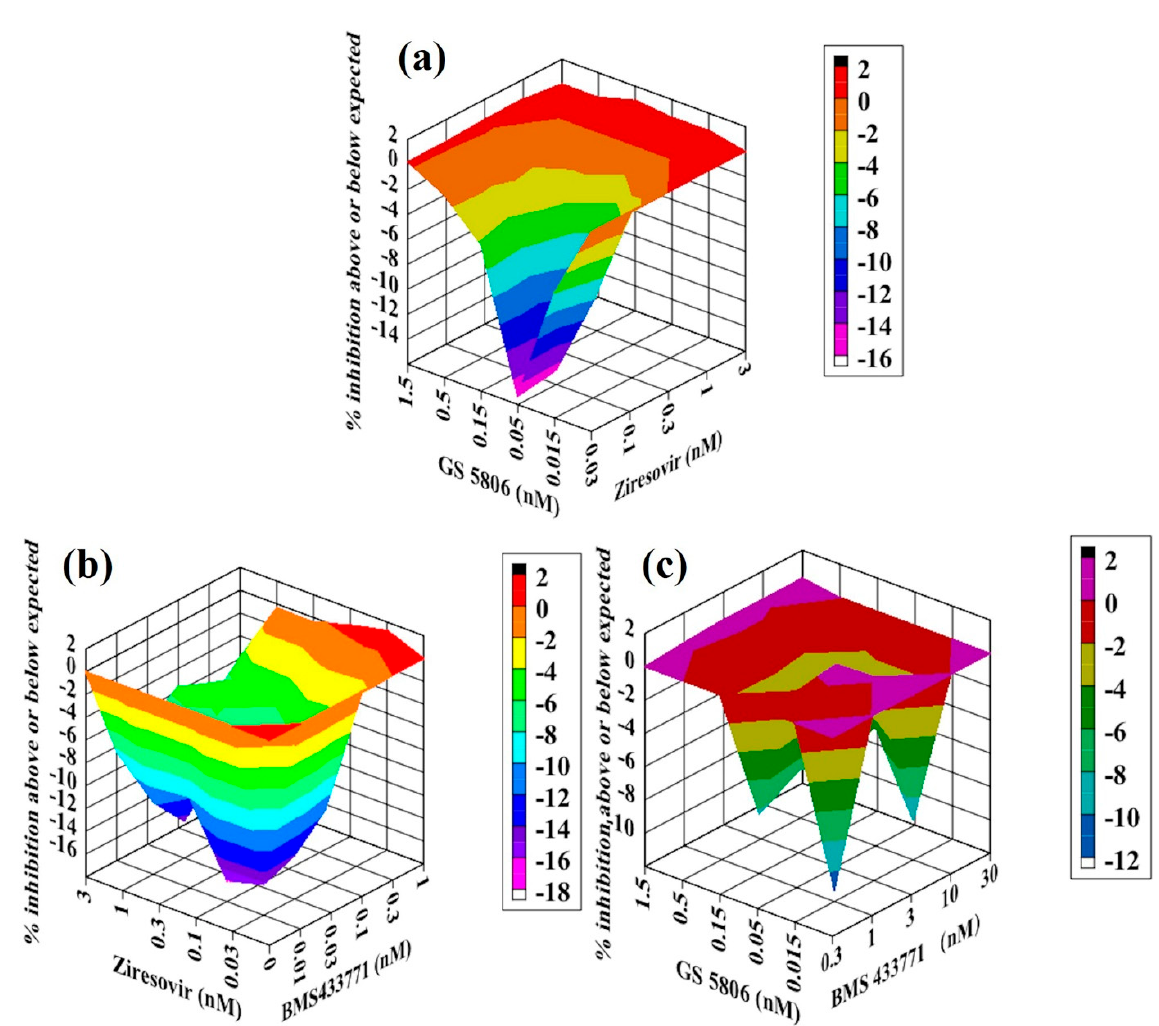
Figure 7. Analysis of compound interactions between fusion inhibitors. HEp-2 cells infected with RSV–Luc were subjected to serial dilutions of GS5806 (( a , b ); 0.015–1.5 nM), Ziresovir (( a , c ); 0.03–3 nM), or BMS433771 (( b , c ); 0.3–30 nM) in a checkerboard method, and results were obtained via a luciferase activity reduction assay ( a – c ). Data shown were obtained using Macsynergy II program at 95% confidence interval and plotted with Delta Graph, and values on the Z-axis represent the mode of interaction between two selected compounds (>0, synergistic effect; <0, antagonistic effect; 0, additive effect). All data points represent averages of three measurements from three experiments.